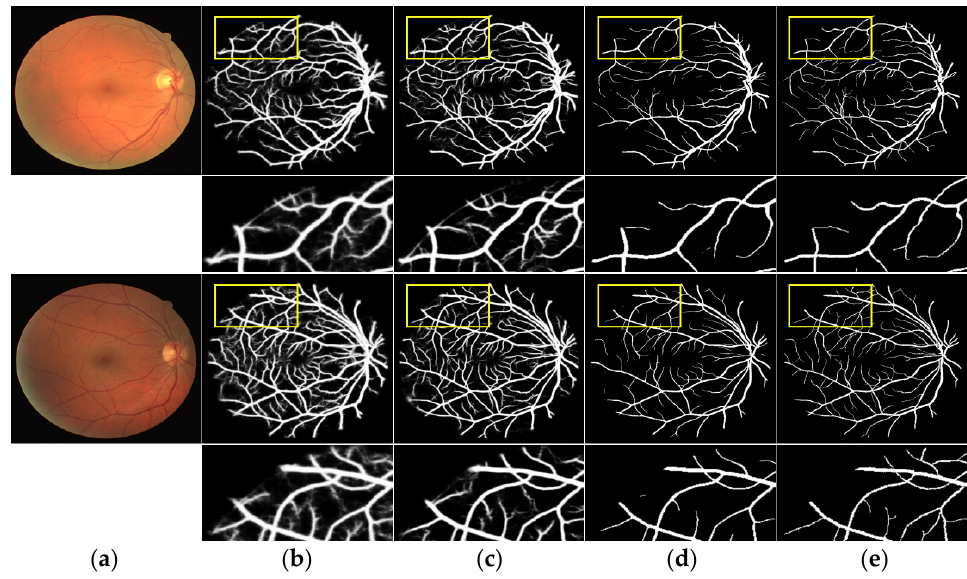
Figure 7. Comparison of LSW-Net + IAC-Loss with advanced segmentation models results on DRIVE. Lines 2 and 4 are the local details. ( a ) Test Image; ( b ) HED; ( c ) DRIU; ( d ) LSW-Net + IAC-Loss (Ours); ( e ) Ground truth.